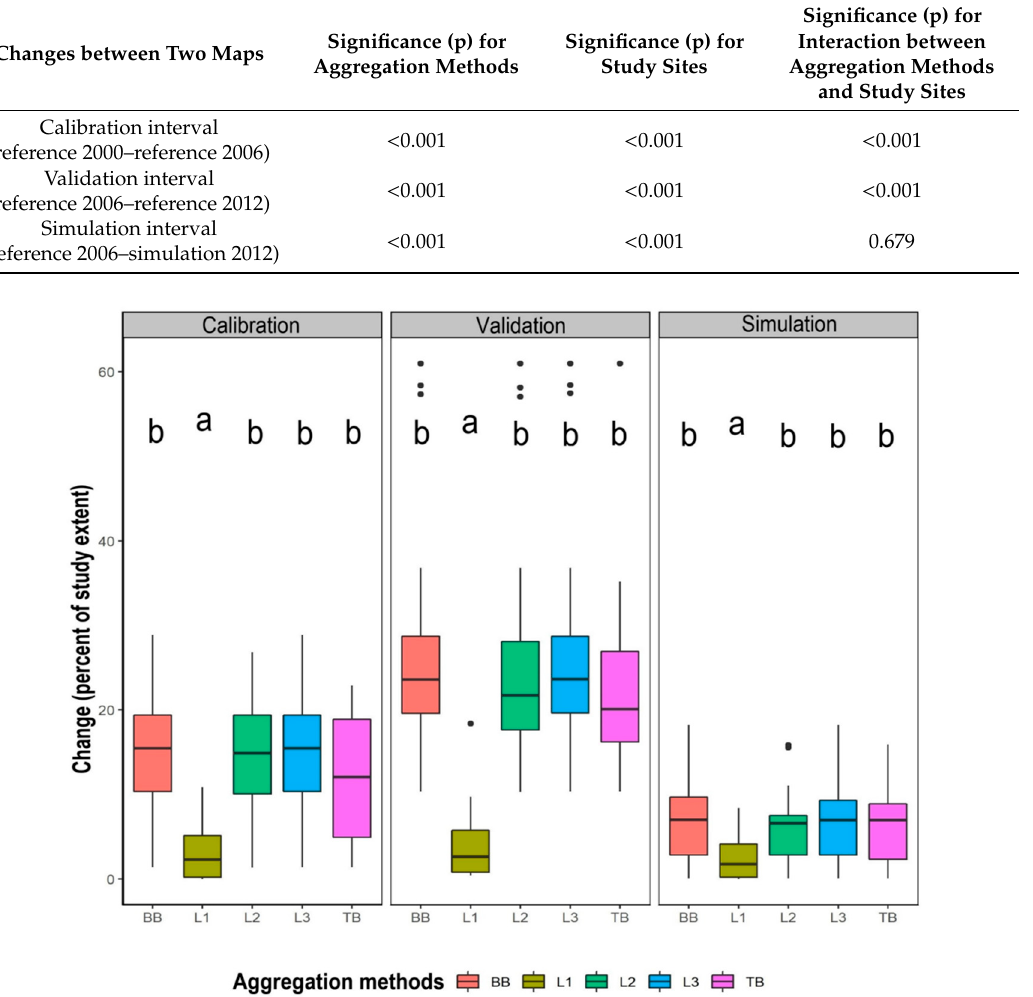
Table 2. Factorial ANOVA results of the percent of changes in the calibration, validation and simulation intervals by aggregation methods (H 0 : medians of calibration intervals, validation intervals and simulation intervals are equal).